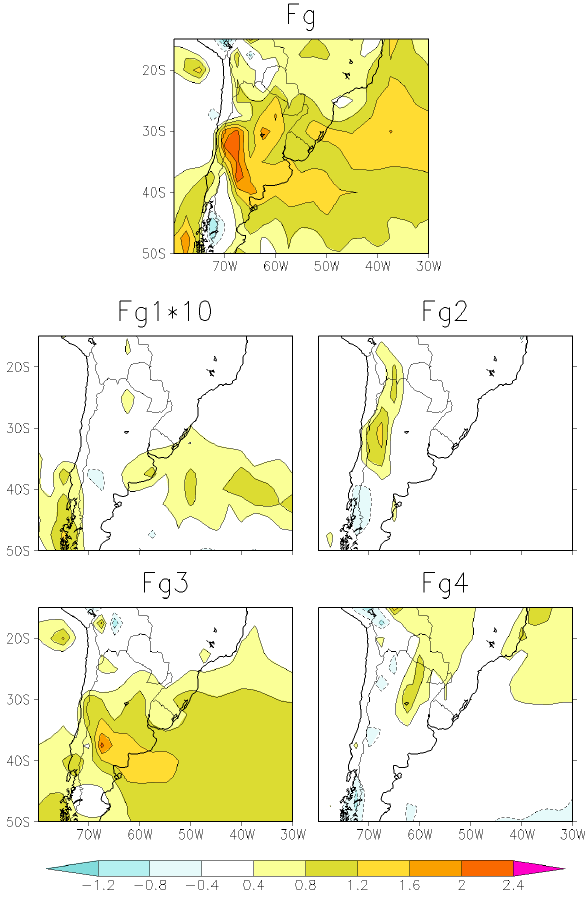
Fig. 1. Climatology of frontogenesis in θ e (K / 100km / day) at 850hPa. Total frontogenesis Fg is the sum of the four terms FG 1 , FG 2 , FG 3 and FG 4 , calculated following Ninomiya (1984).